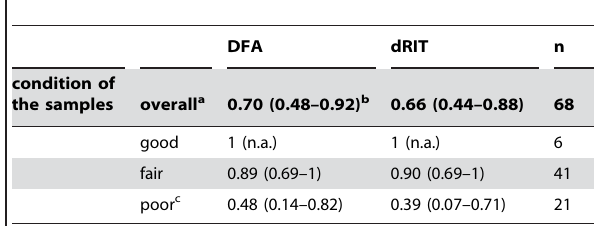
Table 2. Characteristics of the 47 rabies suspicious animals rabies diagnosis (based on DFA)